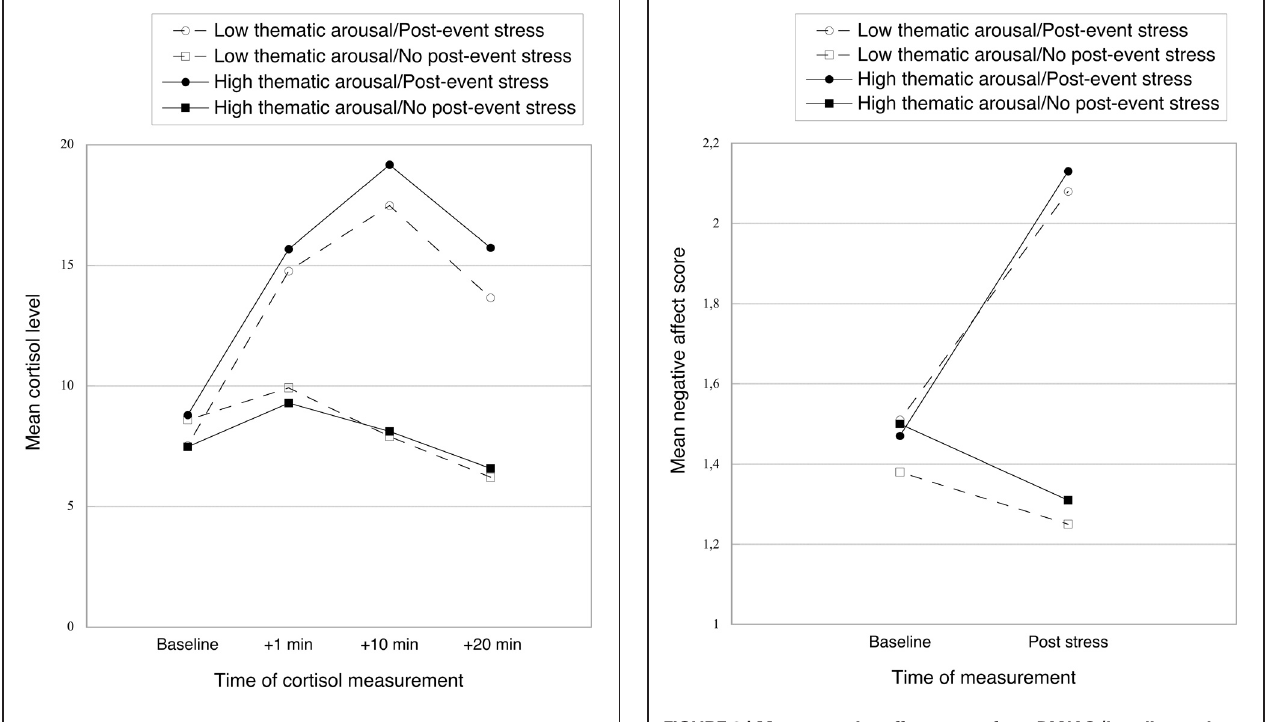
FIGURE 2 | Mean cortisol level (baseline and at 1, 10, and 20min after the post-event stress manipulation) as a function of thematic arousal and post-event stress.